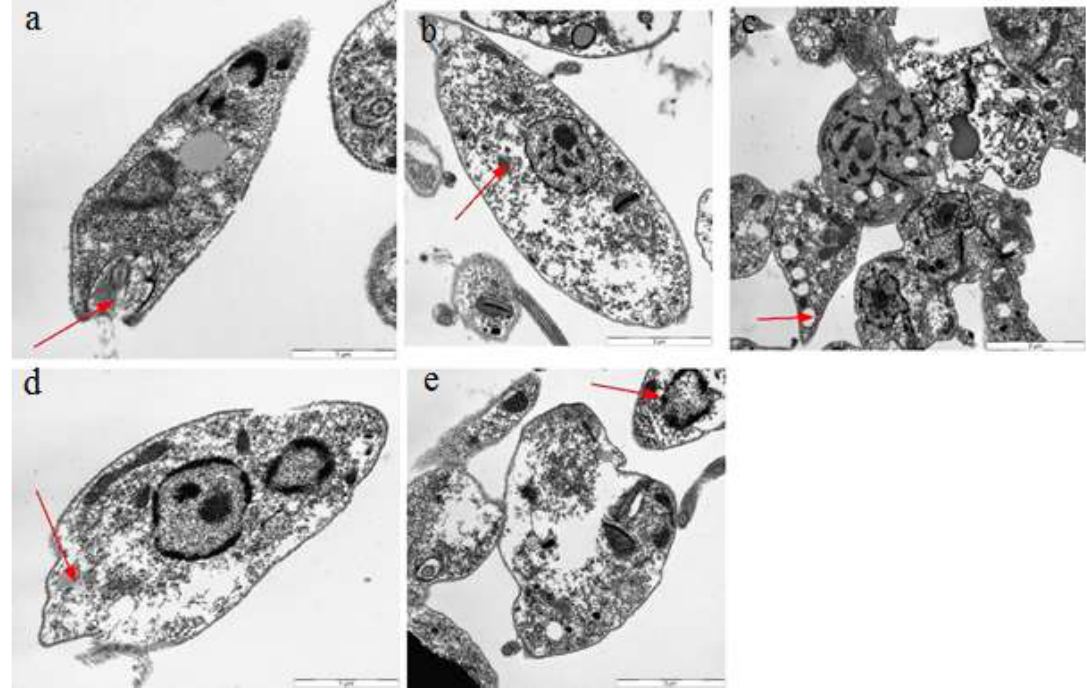
Figure 14. Ultrastructural changes in L. donovani LV82 promastigotes treated with rutin at 500 µg/mL for 72 h. ( a ) Distortion of the flagellar pocket, ( b ) acidocalcisomes, ( c ) large number of vacuoles, ( d ) lipid reservoirs, and ( e ) nuclear condensation.